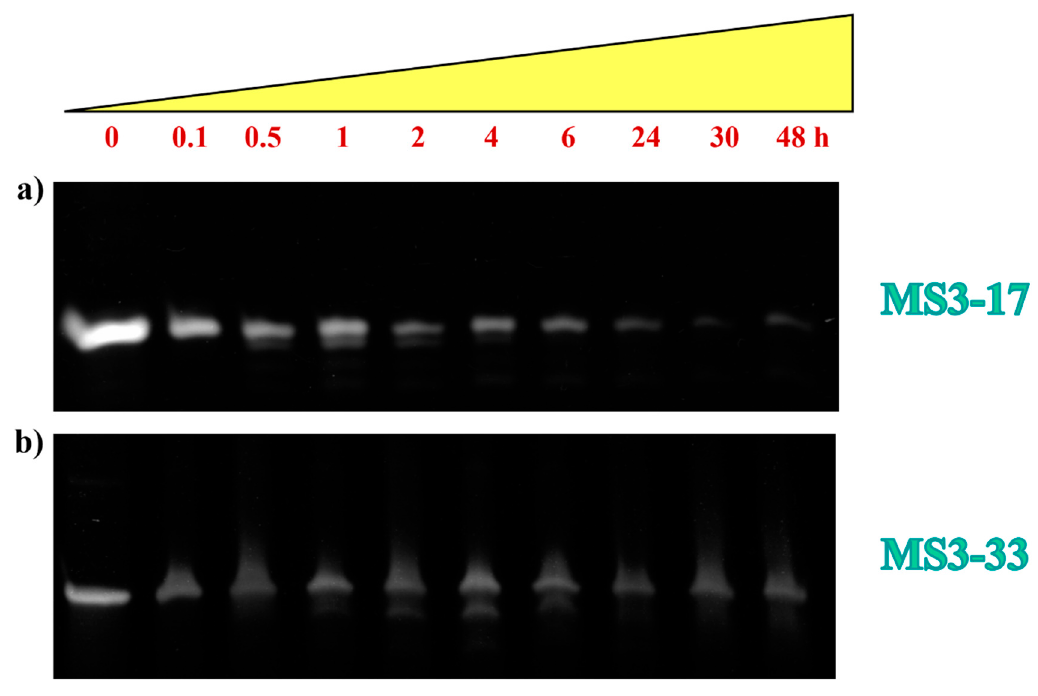
Figure 6. Enzymatic resistance experiments performed on MS3-17 ( a ) and MS3-33 ( b ) incubated in 80% fetal bovine serum (FBS) as monitored by 20% denaturing polyacrylamide gel electrophoresis up to 48 h (time points: 0, 0.1, 0.5, 1, 2, 4, 6, 24, 30, and 48 h). For each compound, a representative 20% denaturing PAGE (8 M urea) is reported. Gels were run at a constant 200 V at r.t. for 3 h in TBE 1X as running buffer.